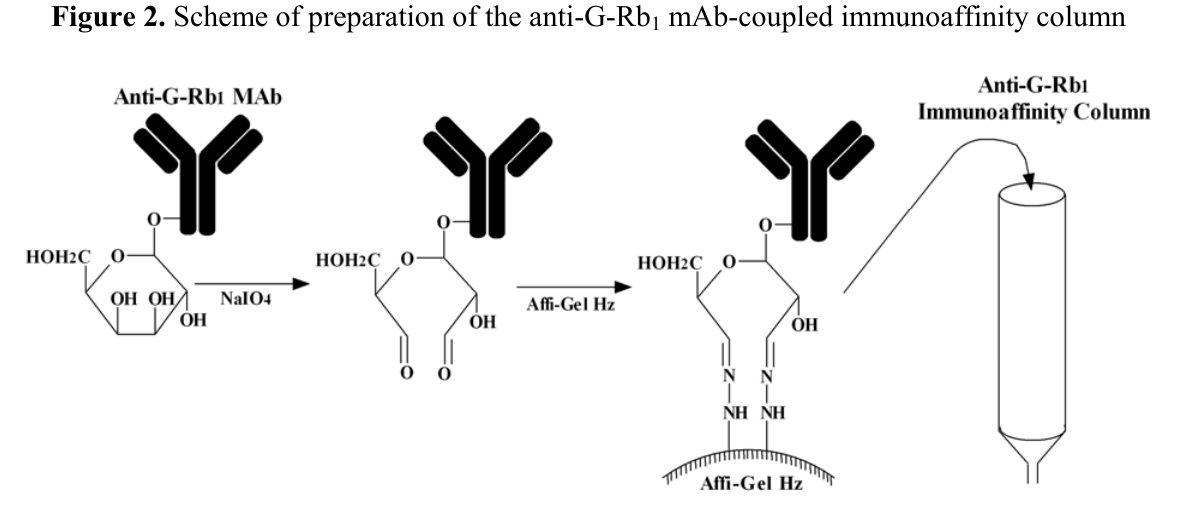
Figure 2. Scheme of preparation of the anti-G-Rb